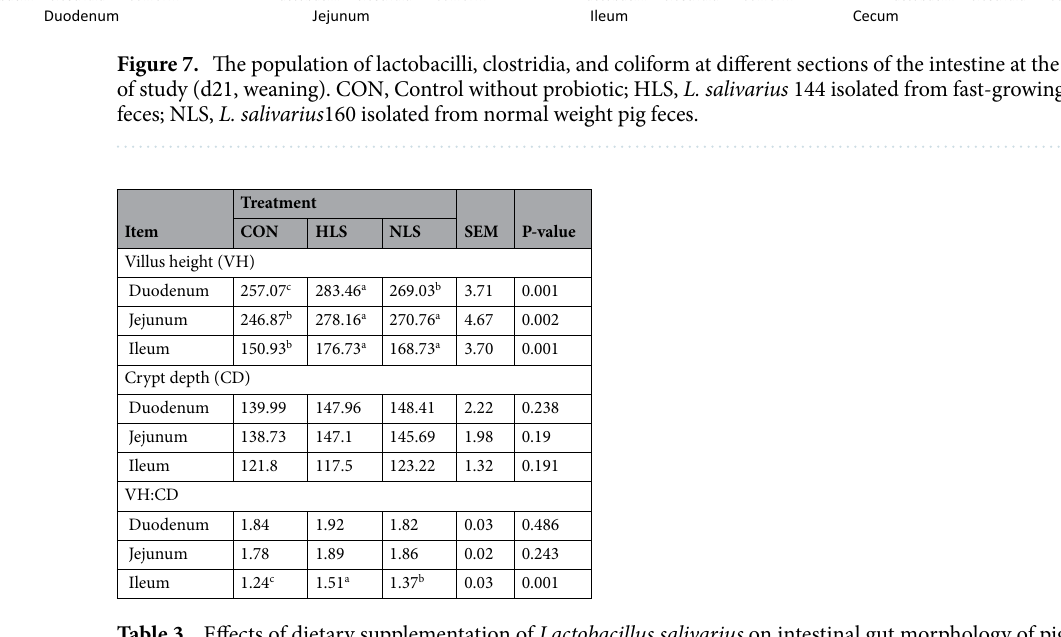
Table 3. Effects of dietary supplementation of Lactobacillus salivarius on intestinal gut morphology of piglets at weaning. CON, Control; HLS, L. salivarius 144 isolated from fast-growing pig feces; NLS, L. salivarius 160 isolated from normal weight pig feces. a-b Means with different superscripts within rows are significantly different at P < 0.05.